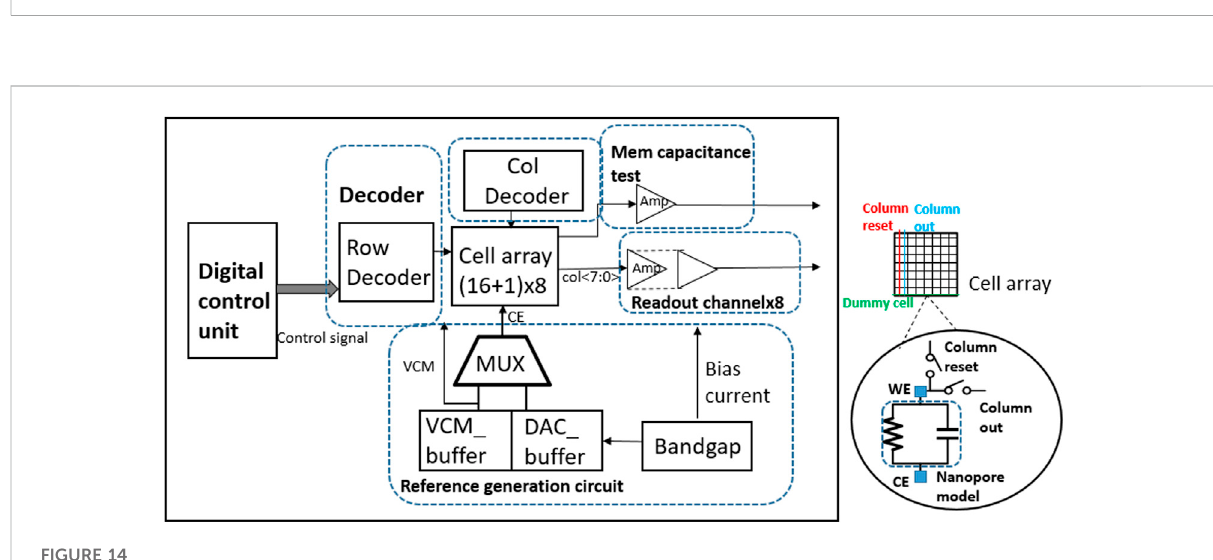
FIGURE 14 System block diagram and cell array architecture (Dong et al.,